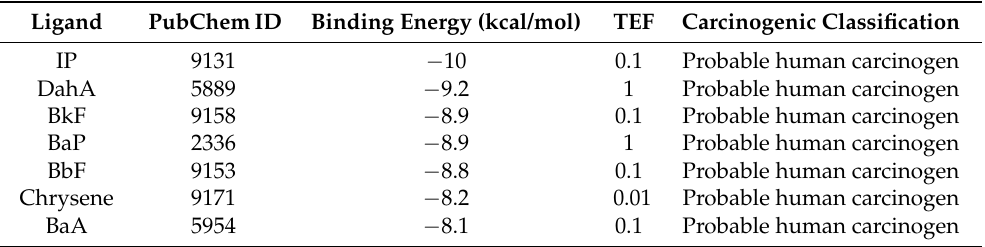
Table 3. Binding energy results of the 7 PAHs using AutoDock Vina; toxic equivalent factors (TEF); and carcinogenic classifications based on the EPA.